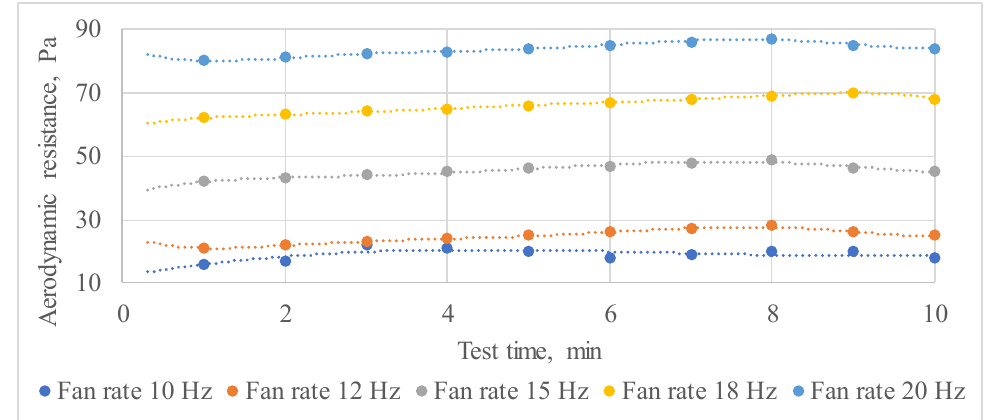
Figure 5. Dependence of the aerodynamic resistance of the apparatus on the fan rate during the test time.